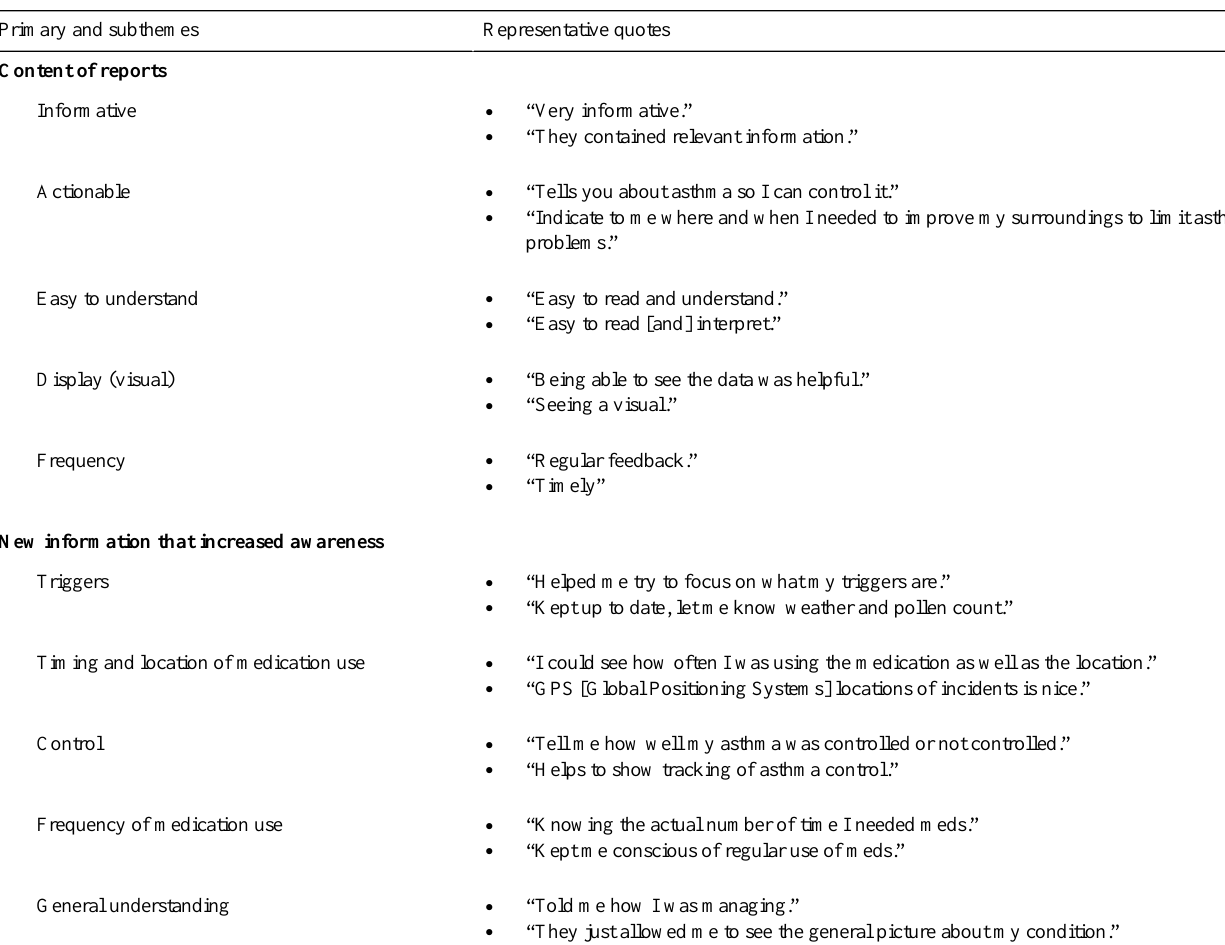
Table 4. Primary themes, subthemes, and selected excerpts from open-ended responses about participants’experience with the data